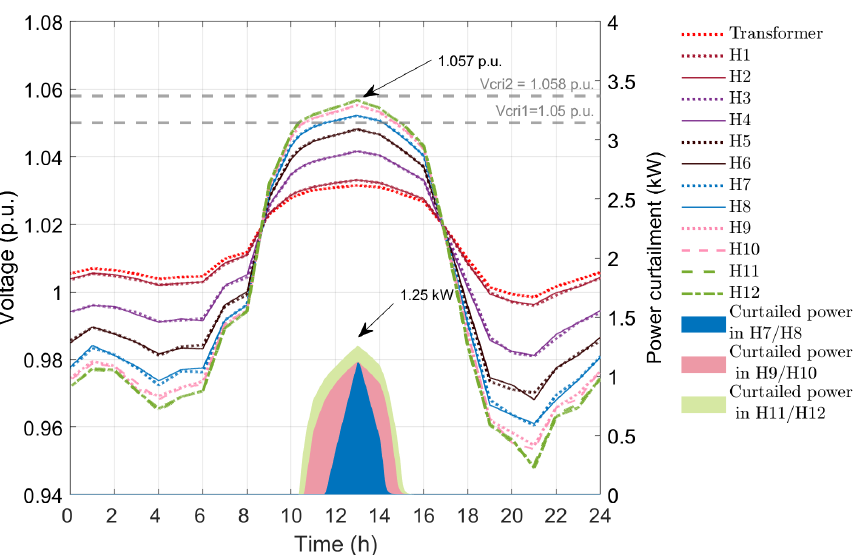
Figure 11. Voltage profile of twelve houses (House 1 to House 12) and curtailed power in linear droop-based APC method using ADP.